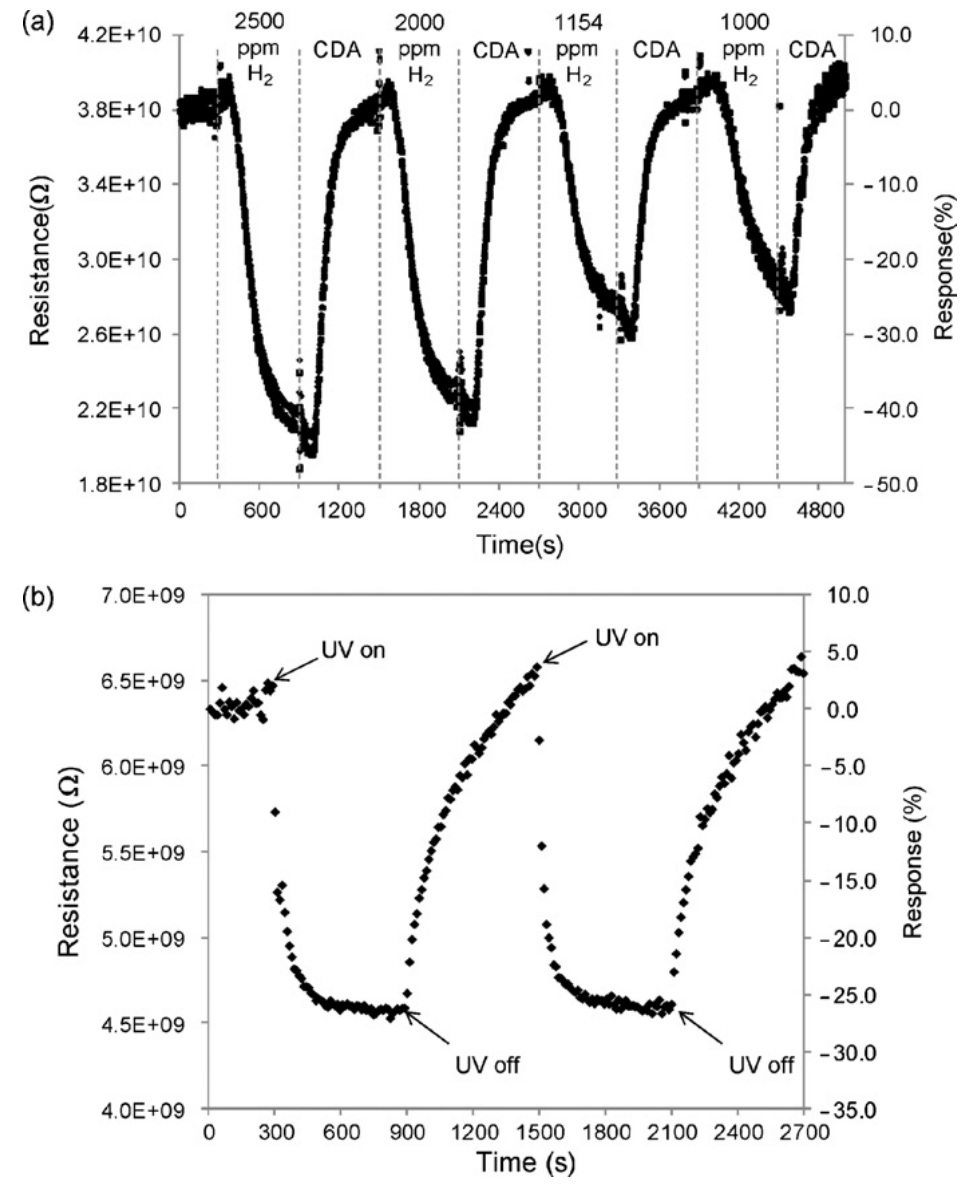
Figure 5. Electrical responses of ZnO NR-on-cloth device to ( a ) various concentrations of H gas and ( b ) UV irradiation. Clean dry air (CDA) was used to flush the chamber before 2 and after each hydrogen injection. Experiments were performed in room